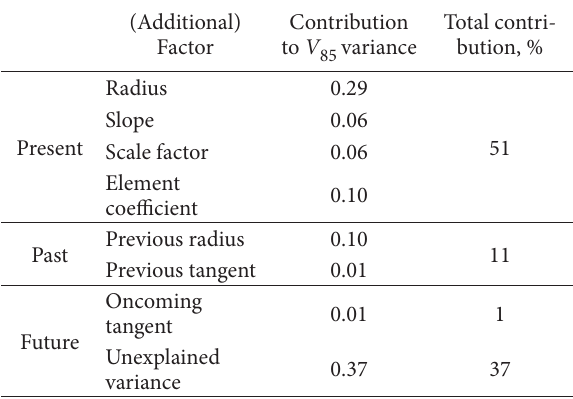
Table 5 . Contribution of present, past and future element on V